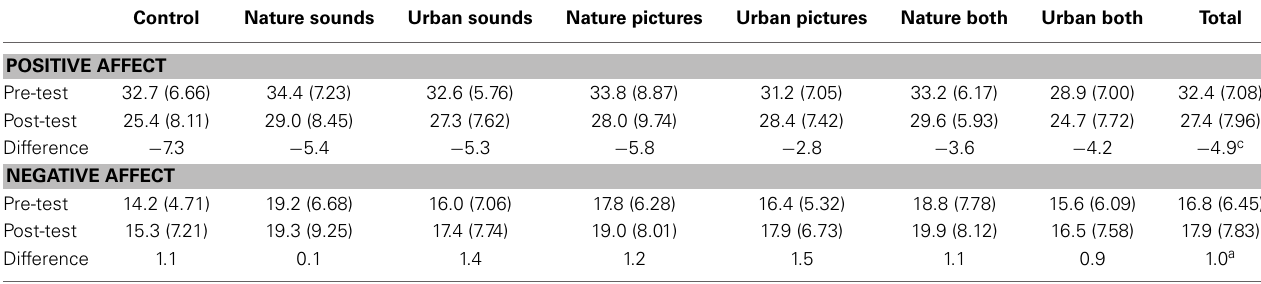
Table 2 | Positive and negative affect scores on the PANAS by condition.